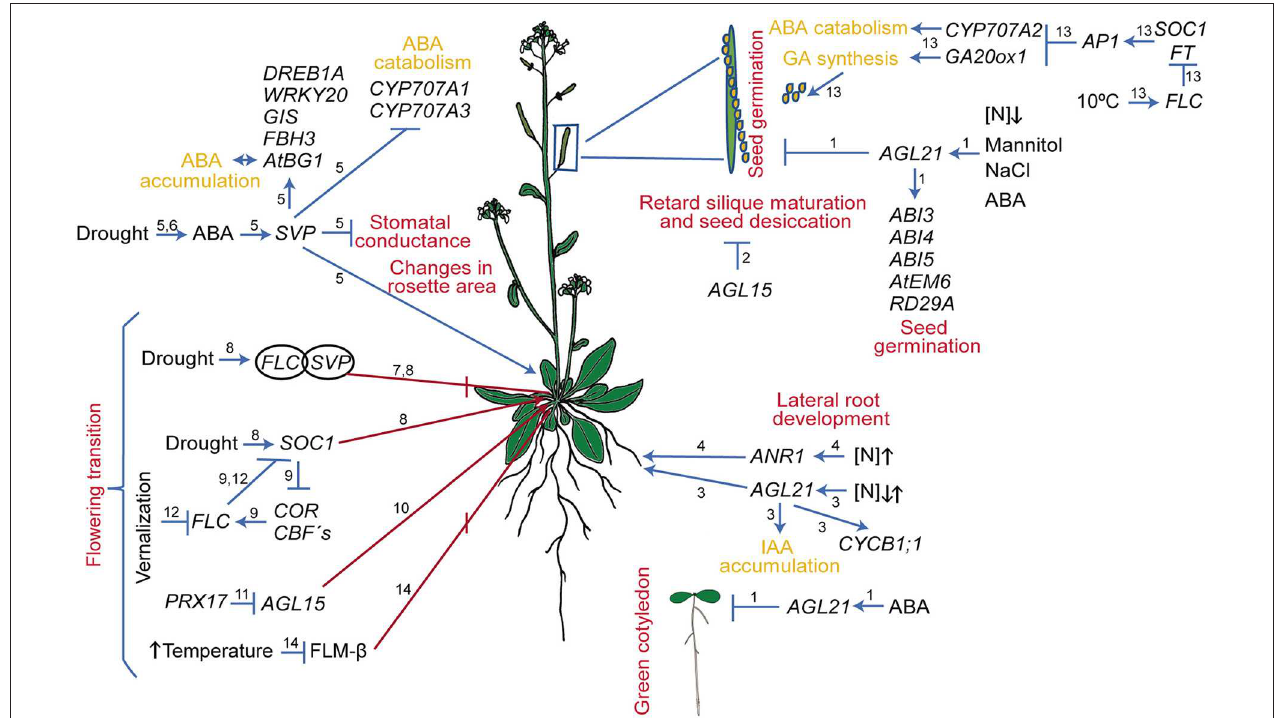
FIGURE 1 | Regulatory circuits mediated by MADS-box genes in response to abiotic stress in Arabidopsis thaliana . The different developmental processes affected are indicated in red. Arrows and bar lines indicate induction and repression, respectively. Numbers on the arrows and/or bars indicate the reference where the data were obtained: (1) Yu et al. (2017); (2) Fang and Fernandez (2002); (3) Yu L.-H. et al. (2014); (4) Zhang and Forde (1998); Gan et al. (2012); (5) Bechtold et al. (2016); (6) Wang et al. (2018); (7) Lee et al. (2007); Li et al. (2008); (8) Riboni et al. (2013, 2016); (9) Seo et al. (2009); (10) Fernandez et al. (2000); (11) Zheng et al. (2009); Cosio et al. (2017); (12) Bloomer and Dean (2017); (13) Chiang et al. (2009); (14) Sureshkumar et al. (2016) and Lutz et al.